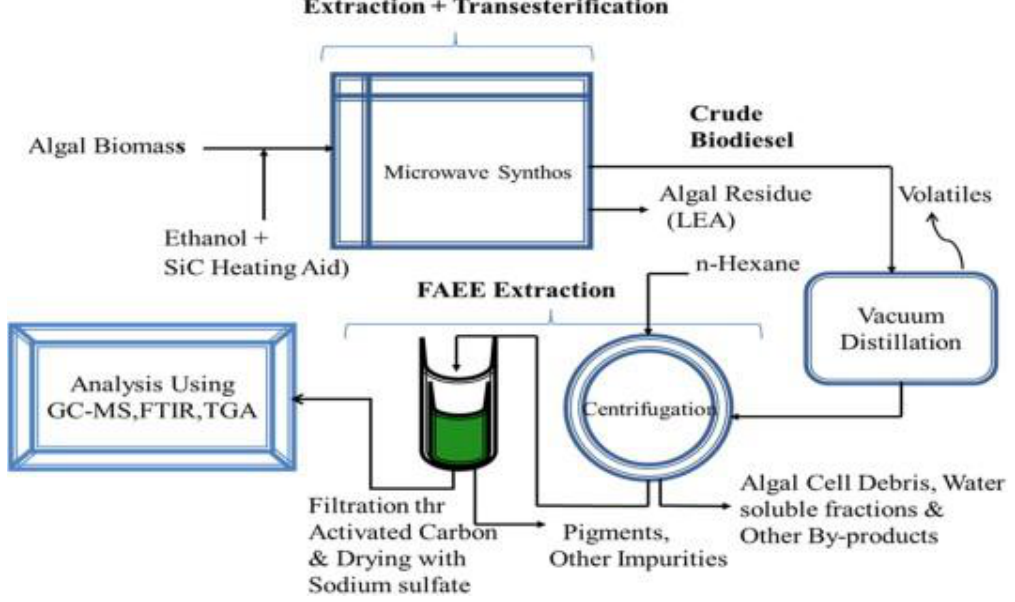
Figure 11. Experimental protocol for the microwave-mediated supercritical ethanol transesterification process for algal biomass.